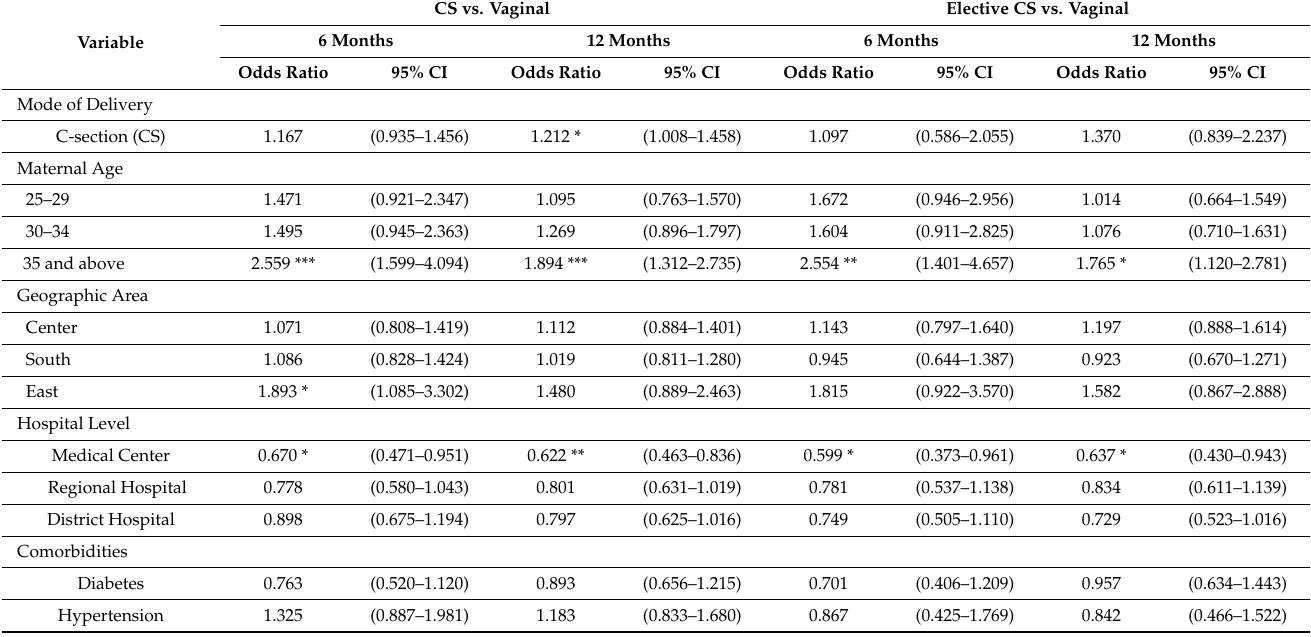
Table 3. Logistic Regressions for Women with History of